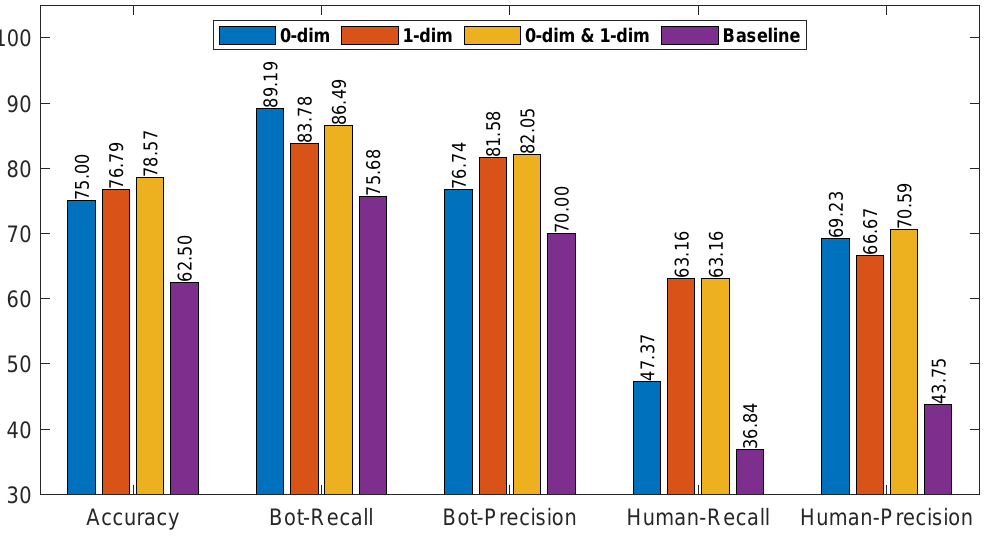
Figure 7. Detection results for different metrics and